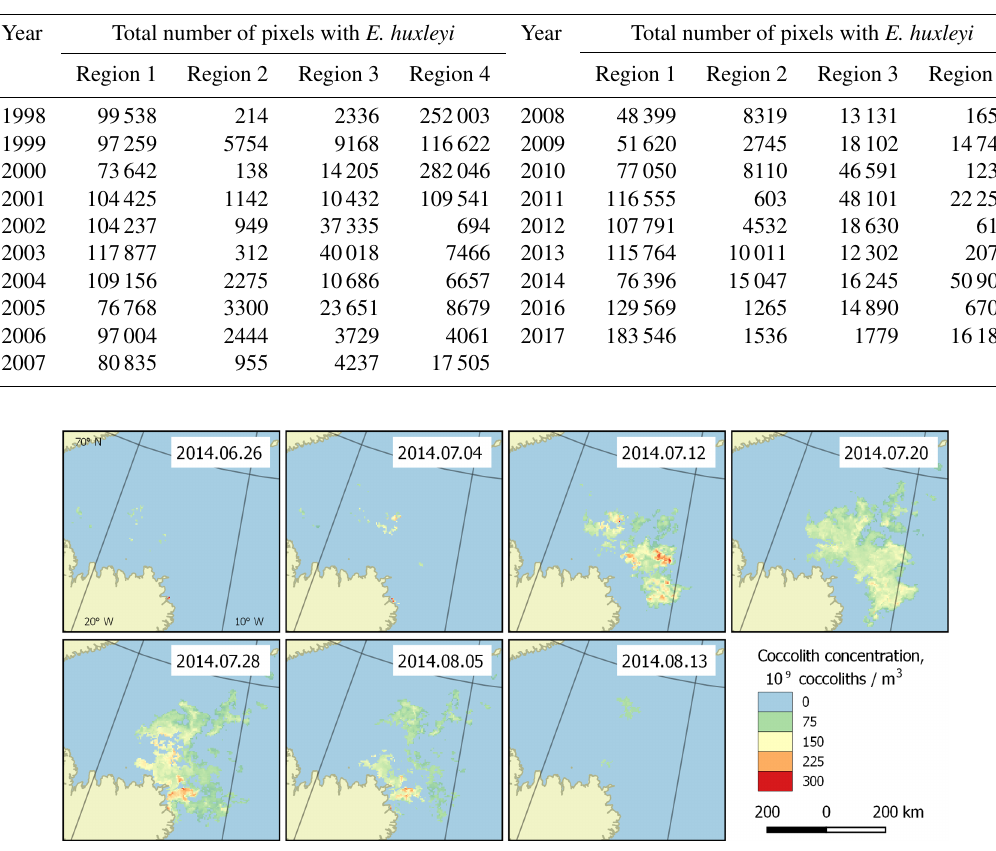
Figure 5. Bloom development in the Greenland Sea (region 2) in June–August 2014. The peak falls on 20 July.